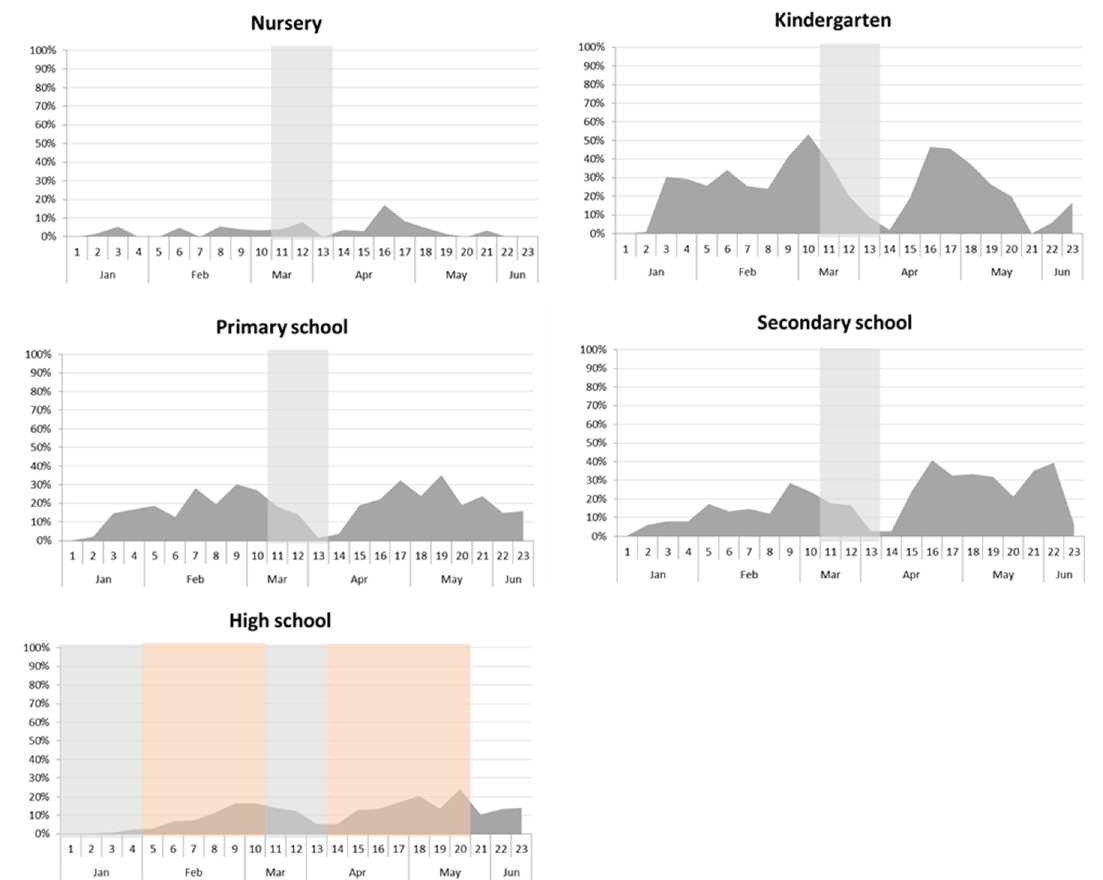
Figure 6. Scholastic cases (secondary cases) out of total infections by age, and by type of school. Gray areas represent periods of school closure; red areas represent those with 50–75% of in-person attendance.